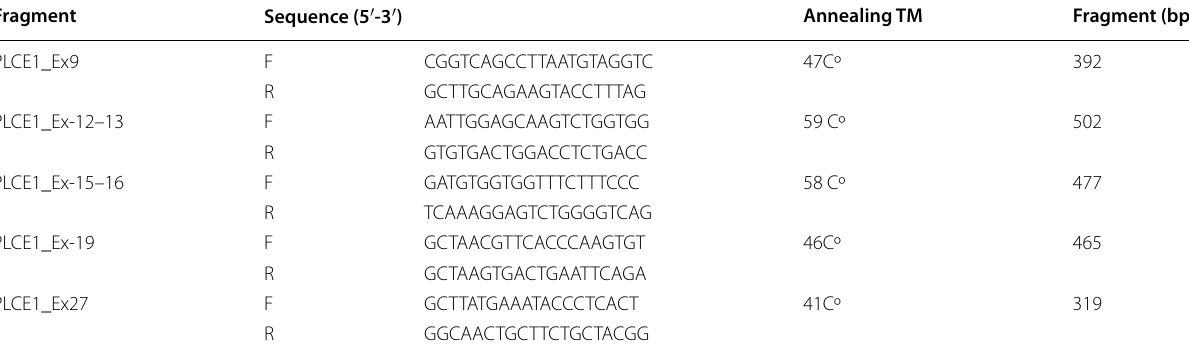
Table 1 The Sequence of PCR primers